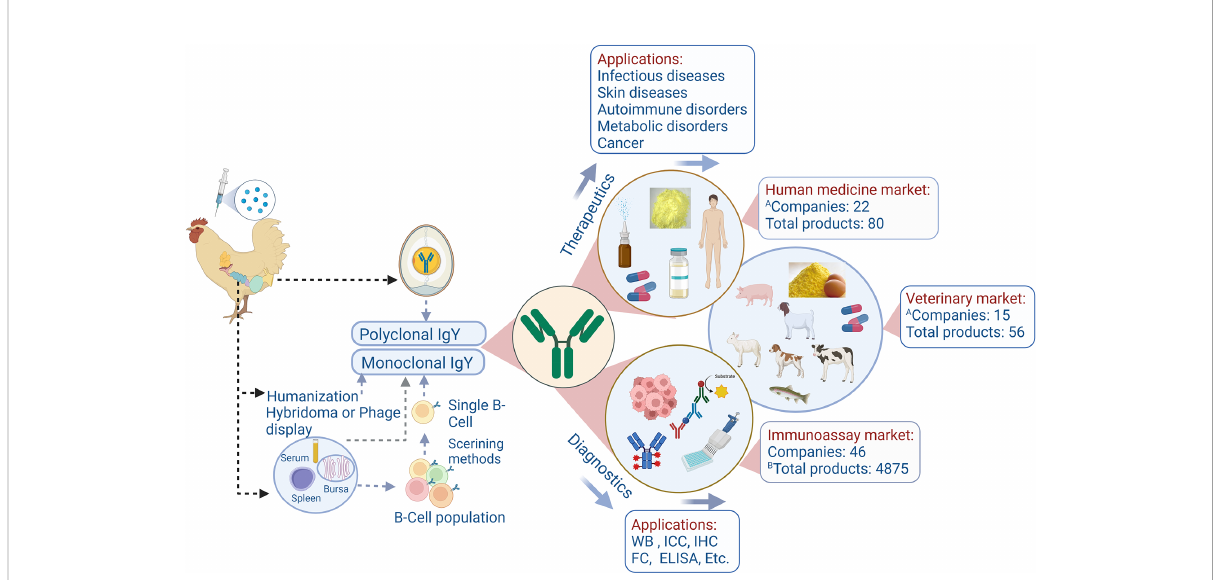
FIGURE 1 Schematic indication of the IgY production, applications, and market status. (A) Number of companies manufacturing IgY-based products for human medicine and veterinary fi elds. (B) Indicated the primary antibody (pAb), secondary antibody (sAb), and other products (monoclonal antibody, tag antibody, and diagnostic kit). ELISA, enzyme-linked immunosorbent assay; IC, immunocytochemistry; IHC, immunohistochemistry; FC, fl owcytometry; WB, western blot. This drawing was created with